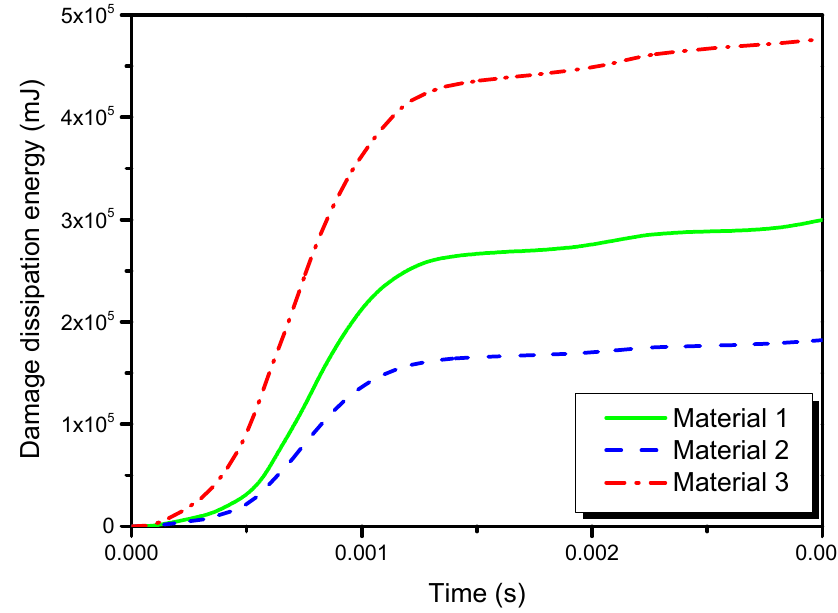
Figure 16. Time histories of the damage dissipation energy in the three models.